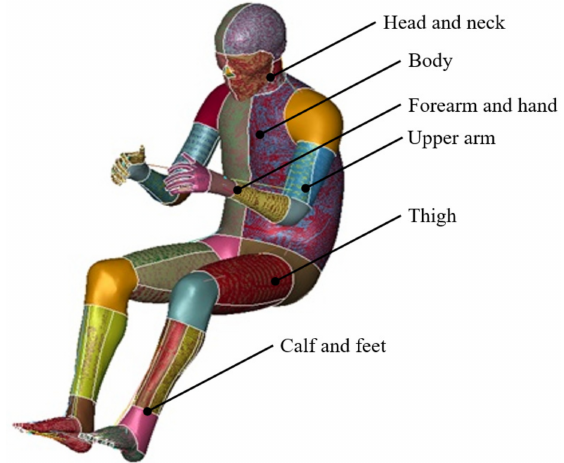
Figure 2. Toyota 50 percentile dummy model.